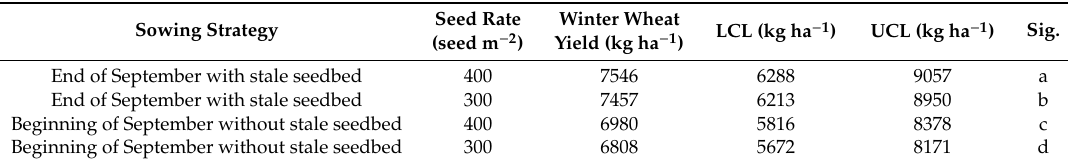
Table 2. Summary of generalized linear mixed model results with winter wheat yield as dependent variable. LCL = lower confidence limit, UCL = upper confidence limit, Sig. = treatments with di ff erent lowercase letters are significantly di ff erent at α =